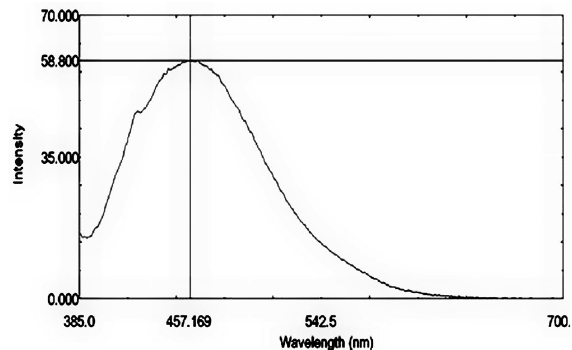
Figure 5. Fluorescence emission spectrum of polymer P o HOBPD (λex: 373 nm, λem: 457